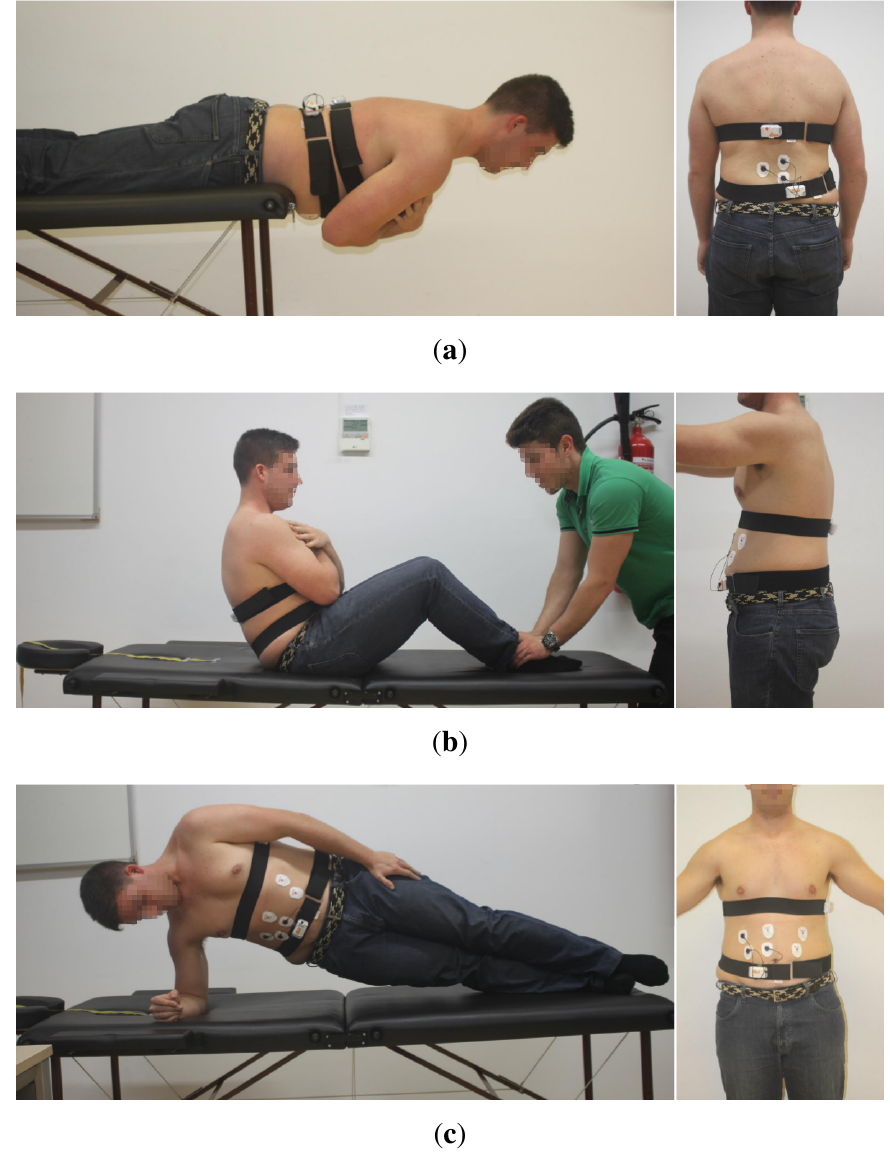
Figure 3. Sensor deployment for the ( a ) STEET, ( b ) TCSET and ( c ) SBET